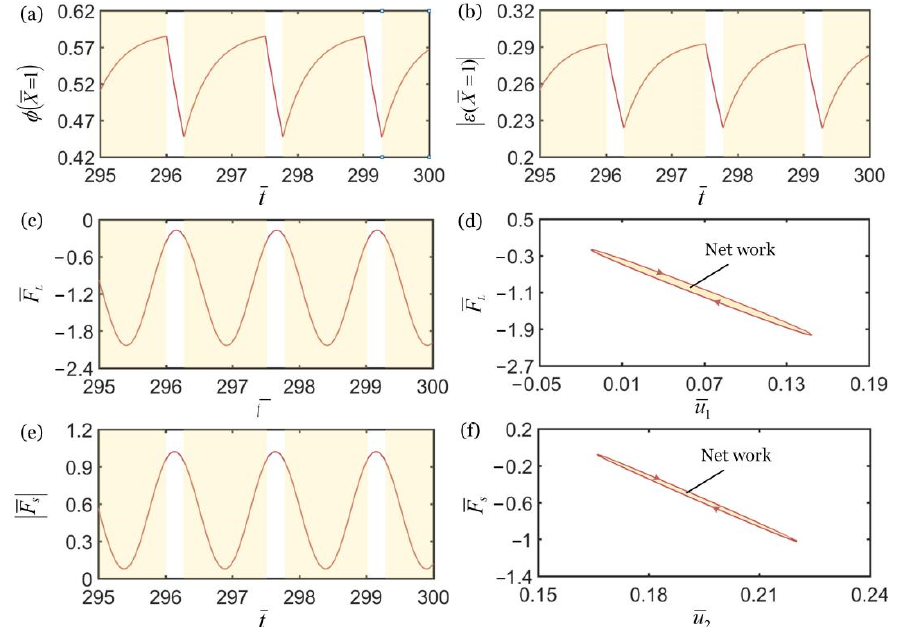
Figure 5. Mechanism of self-excited oscillation in in-phase regime of k 2 = 16 in Figure 2. ( a ) ϕ (cid:12) (cid:1)(cid:12) (cid:0) X = 1 vs. t . ( b ) (cid:12) ε (cid:12) vs. t . ( c ) F L vs. t . ( d ) F L vs. u 1 . ( e ) F s vs. t . ( f ) F s vs. u 2 . In Figure 3d,f, the area enclosed by the closed loop represents the net work done by the tensions of the LCE fiber and spring, which compensates for the damping dissipation to maintain the oscillations of two coupled oscillators.